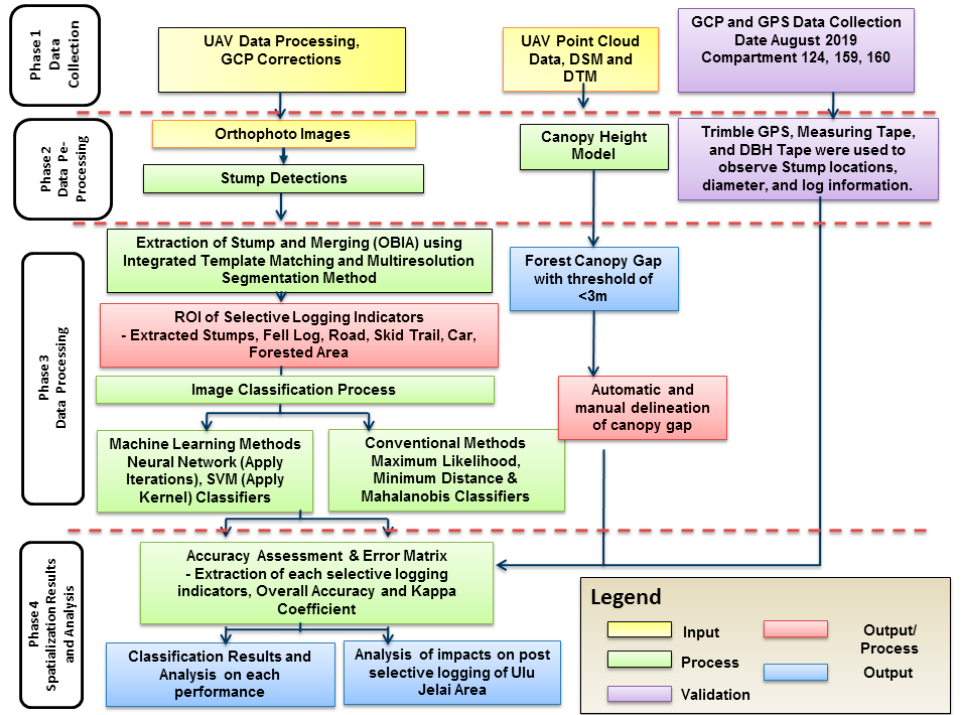
Figure 2. The overall methodological framework on detecting impacts of selective logging.